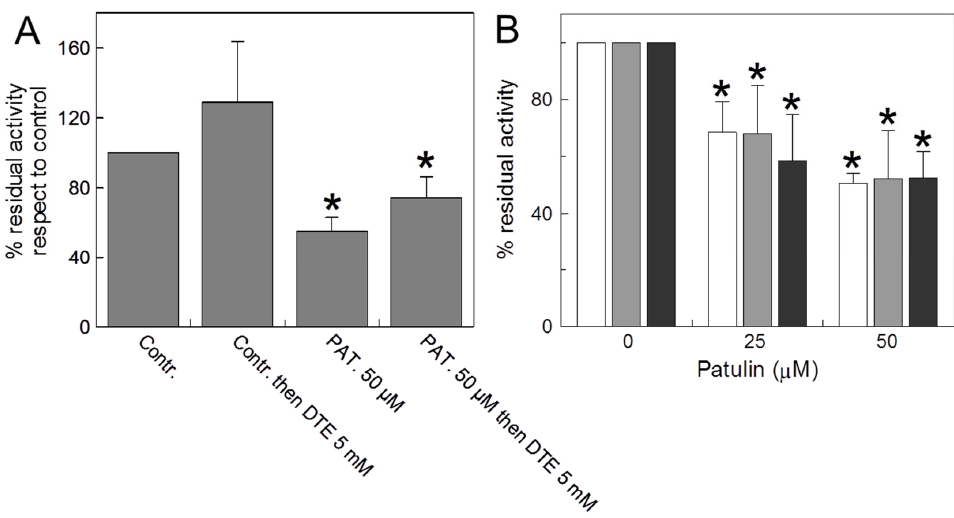
Figure 3. ( A ) Reversal of PAT inhibition on recombinant protein by DTE. The carnitine homo-exchange transport activity was measured, as described in Materials and Methods, adding 0.1 mM [ 3 H] car- nitine to proteoliposomes reconstituted with the recombinant WT CAC containing 15 mM internal carnitine in the absence or presence of 50 µM PAT, added 30 min before the labelled substrate. 5 mM dithioerythritol (DTE) was added 1 min before the transport assay in a control and PAT treated aliquot, respectively. The transport was stopped after 30 min by 1.5 mM NEM. ( B ) Time-dependent reactivity of the same PAT solution on the recombinant WT protein . Proteoliposomes reconstituted with the WT CAC were incubated by the same PAT solution (25 and 50 µM) after 0.5 h, 24 h and 72 h (white, grey and black bars, respectively) and then the transport activity was measured by adding 0.1 mM [ 3 H]-carnitine and stopped after 30 min as described in Materials and Methods. The data of both panels are expressed as a percentage of the residual activity compared to the control, without PAT treatment, and are means ± SD from three independent experiments; sig- nificantly different from the respective control as estimated by Student’s t-test (* p < 0.01). To investigate PAT interactions with residues of the substrate binding area, a pro- tection experiment was performed in which carnitine was added to the CAC at different concentrations before the inhibitor. As shown in Figure 4, the addition of carnitine both at 0.5 and 10 mM, partially prevented PAT inhibition, most likely because the target of the mycotoxin could be the thiol group of C136 located on the bottom of the substrate bind- ing area, thus suggesting a steric hindrance to the substrate passage through the protein water-filled cavity. To reject nonspecific effects independent of mycotoxin, carnitine was added to some samples in the absence of PAT, before the transport activity was started. No variations were observed (Figure 4)